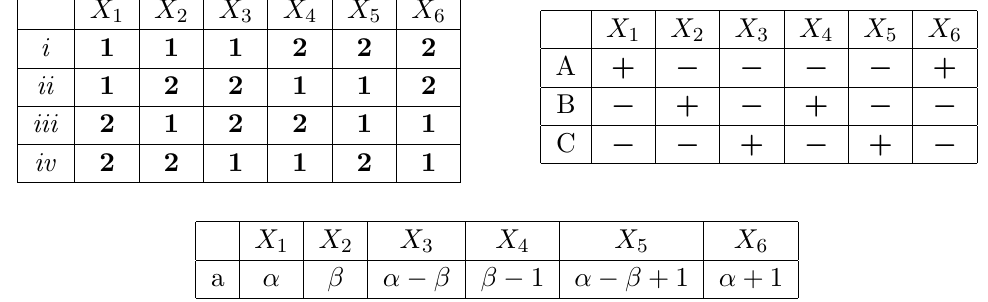
Table 18. The same as table 17 for diagram 3.c in (cid:12)gure